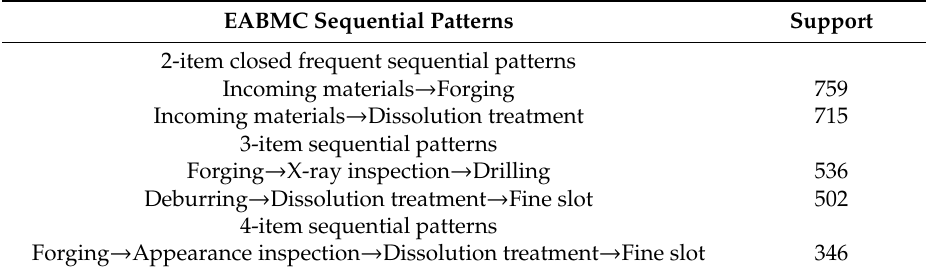
Table 7. Part of EABMC frequent sequential patterns for the manufacturing